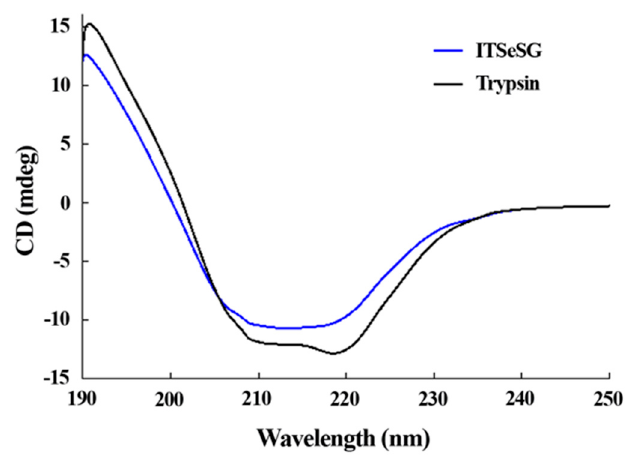
Figure 3. Circular dichroism spectra of ITSeSG (blue) and Trypsin (black) monitored between 190 and 260 nm.